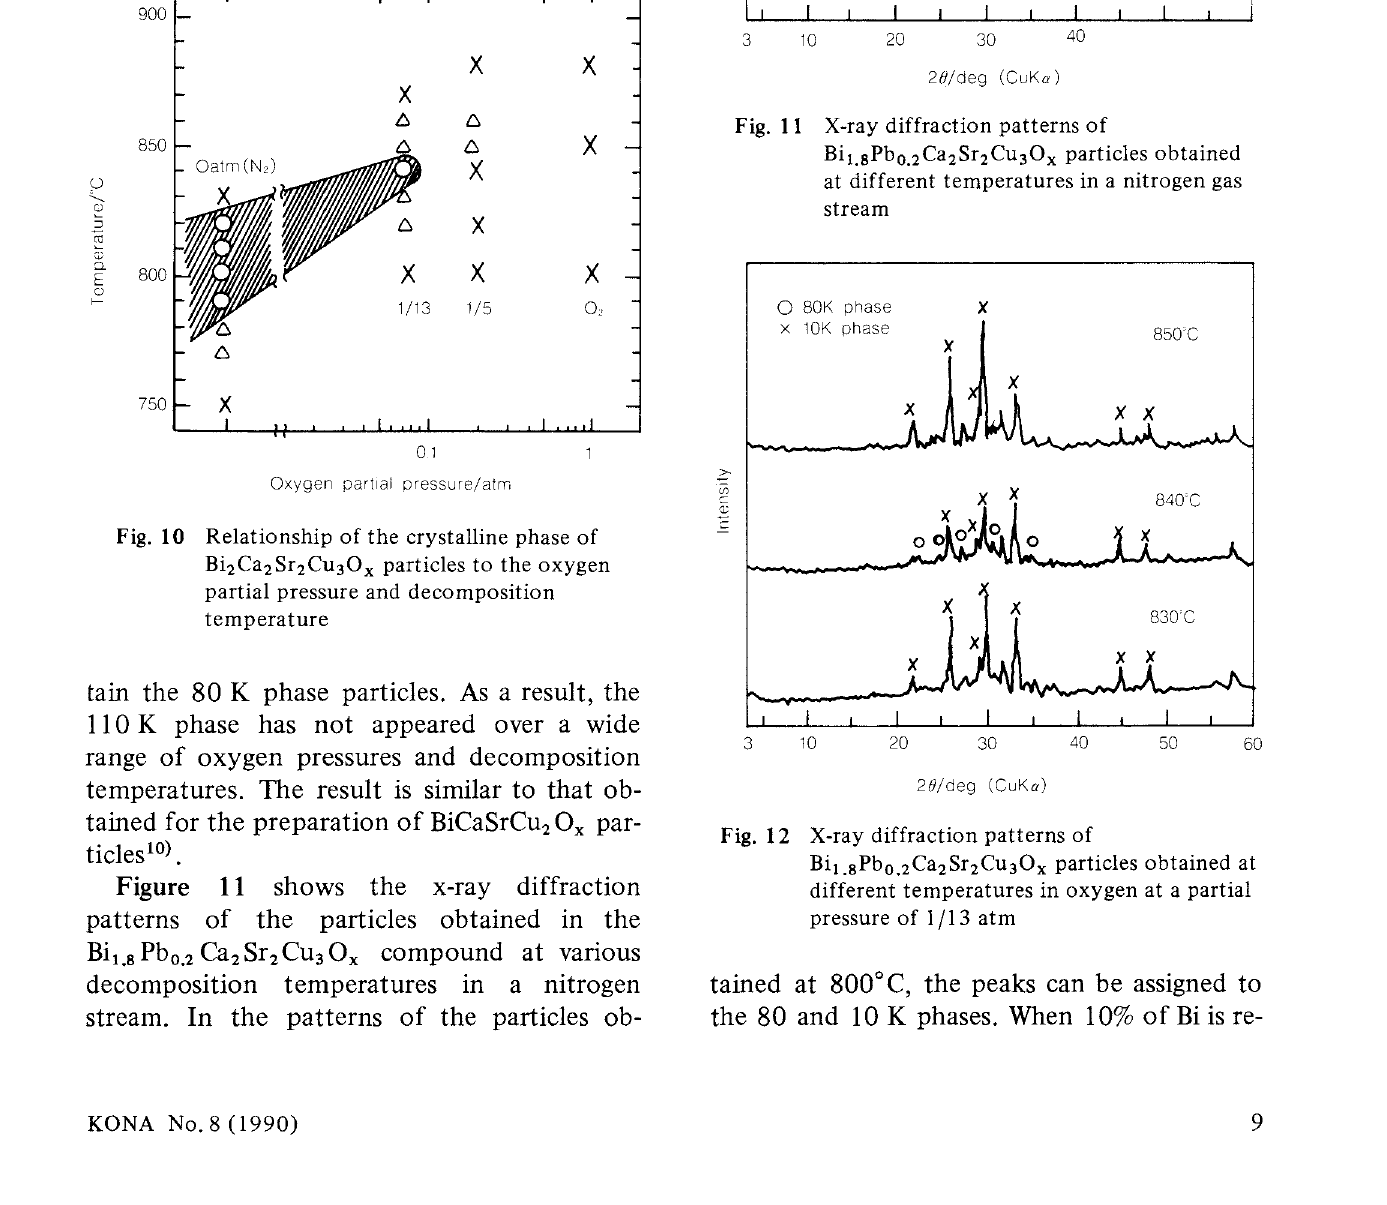
Fig. 11 X-ray diffraction patterns of Bi1.8Pb 0• 2Ca2Sr2Cu30x particles obtained at different temperatures in a nitrogen gas stream